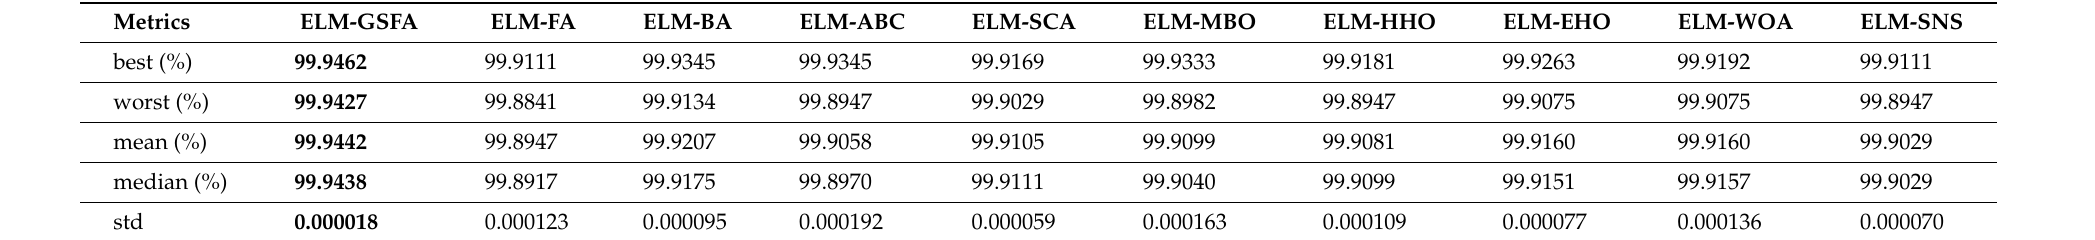
Table 3. ELM Credit Card Fraud NO SMOTE—general metrics.